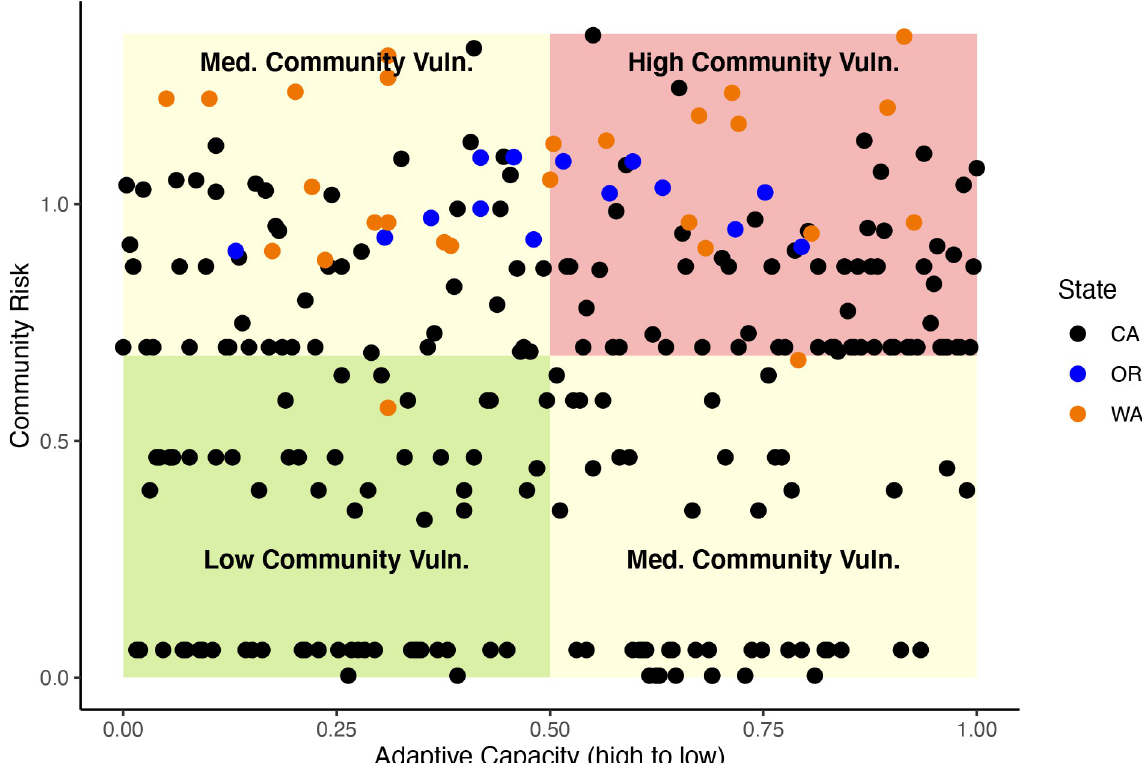
Fig 5. Community vulnerability as a function of community risk versus adaptive capacity (where greater values = lower adaptive capacity). Quadrants represent high, medium, or low community vulnerability where communities can have medium vulnerability either be having low adaptive capacity (and low risk) or high adaptive capacity but high risk. Points are color coordinated by state. All states have communities with high vulnerability but the most vulnerable communities are disproportionately represented in Washington and California.